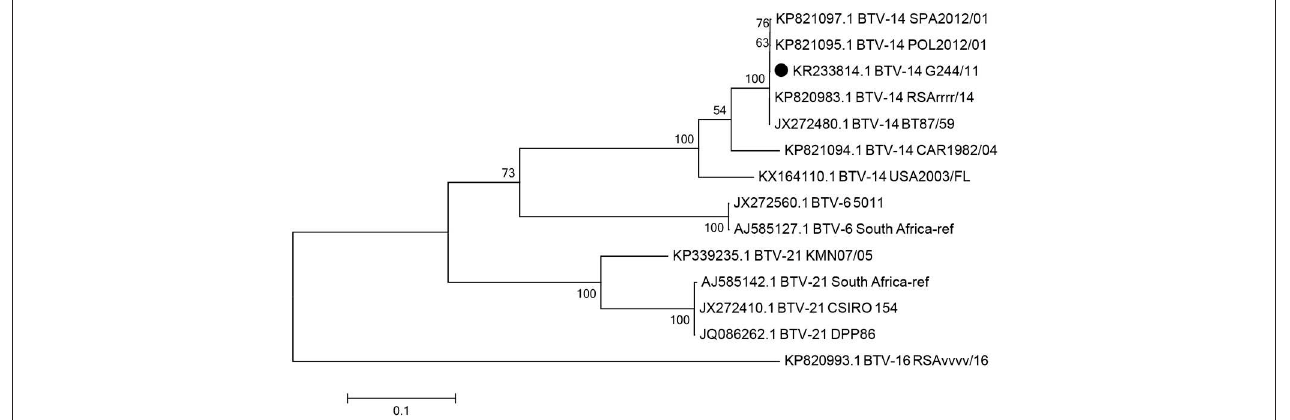
FIGURE 2 | The maximum likelihood phylogenetic tree showing the relationships of the complete Seg-2 sequences (2,922 nt) of the G244/11 strain and other BTV strains of the Nucleotype C (BTV-21, BTV-6, BTV-14). The phylogenetic tree was constructed using MEGA 7. The percentage of replicated trees in which the associated taxa clustered together in the bootstrap test (500 replicates) with a percentage higher than 54 are shown next to the branches. The Russian BTV G244/11 strain isolated in the Smolensk region in 2011 is indicated by the black circle.